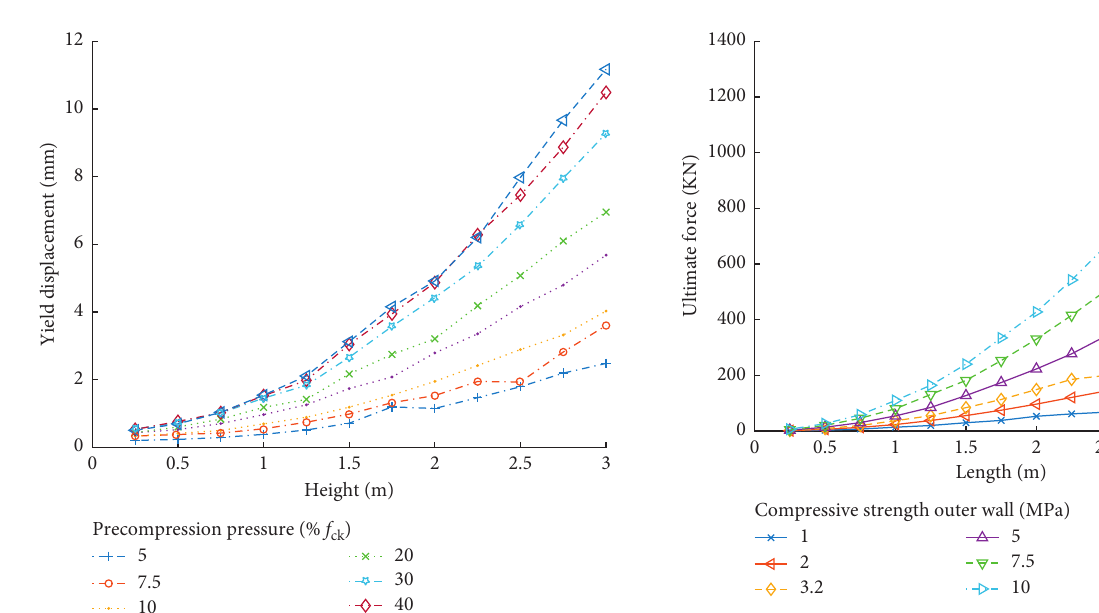
Figure 8: Ultimate force vs length for varying compressive